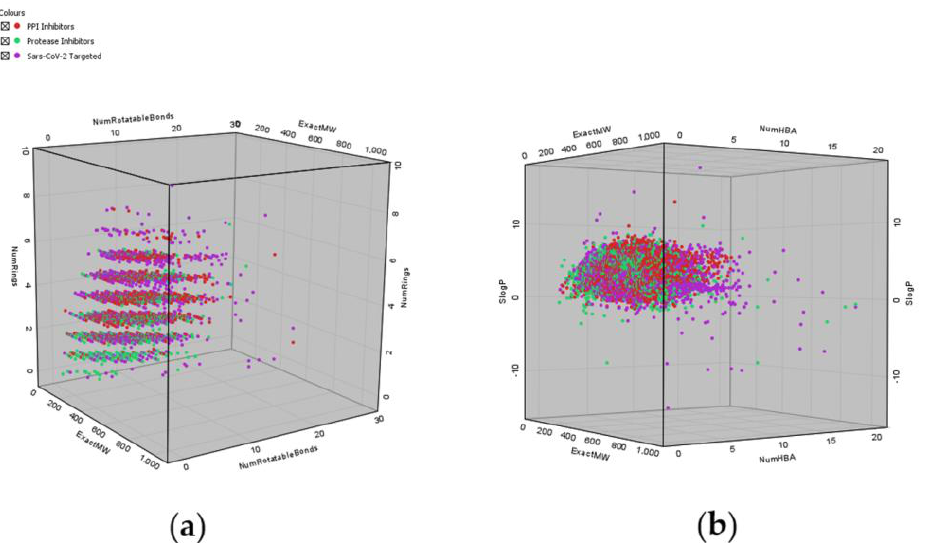
Figure 11. ( a ) Distribution of Molecular Weight (ExactMW), number of rotatable bonds (NumRotat- ableBonds) and number of rings (NumRings) for all joined libraries represented in a spatial diagram. ( b ) Distribution of Molecular Weight (ExactMW), number of hydrogen bond acceptors (NumHBA) and SlogP for all joined libraries represented in a spatial diagram.